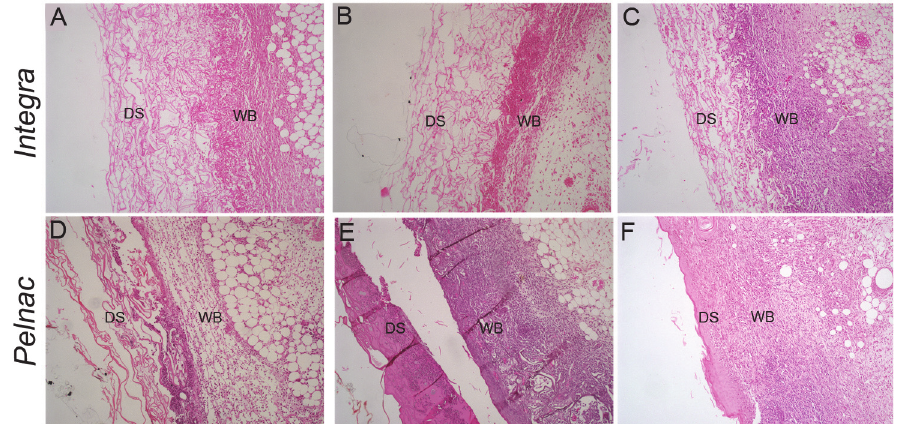
Fig 1. Histological aspects of wounds treated with dermal substitutes. HE-stained transversal sections of a full-thickness skin wound treated with (A-C) Integra or (D-F) Pelnac collected at (A, D) 3, (B, E) 6 and (C, F) 9 days after the procedure show a clear distinction between the dermal substitute (DM) and the wound bed (WB). Original magnification 100X.